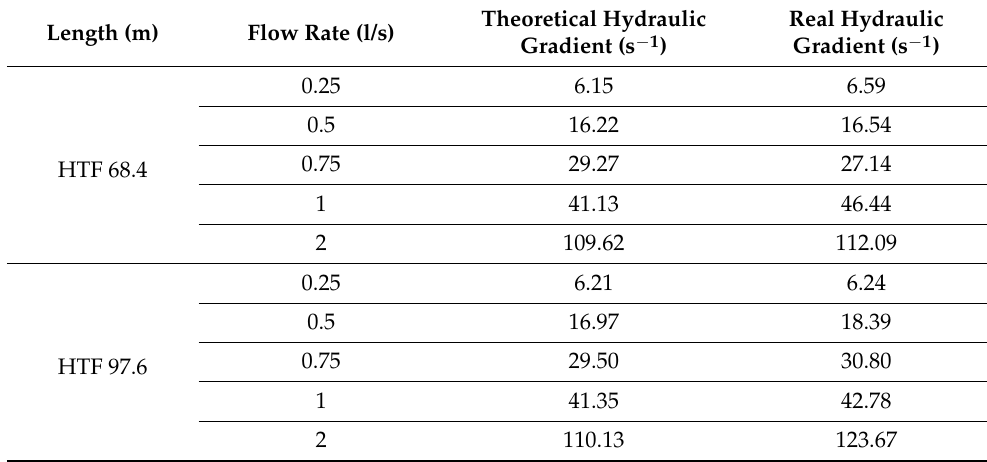
Table 3. Theoretical velocity gradient and real velocity gradient of the